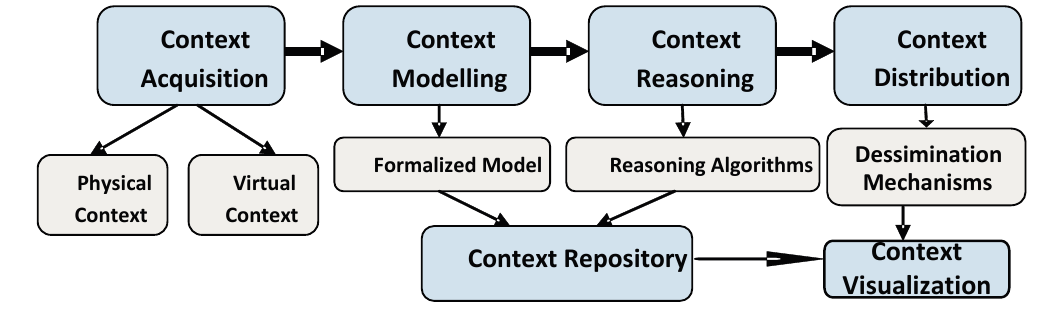
Figure 1. General context